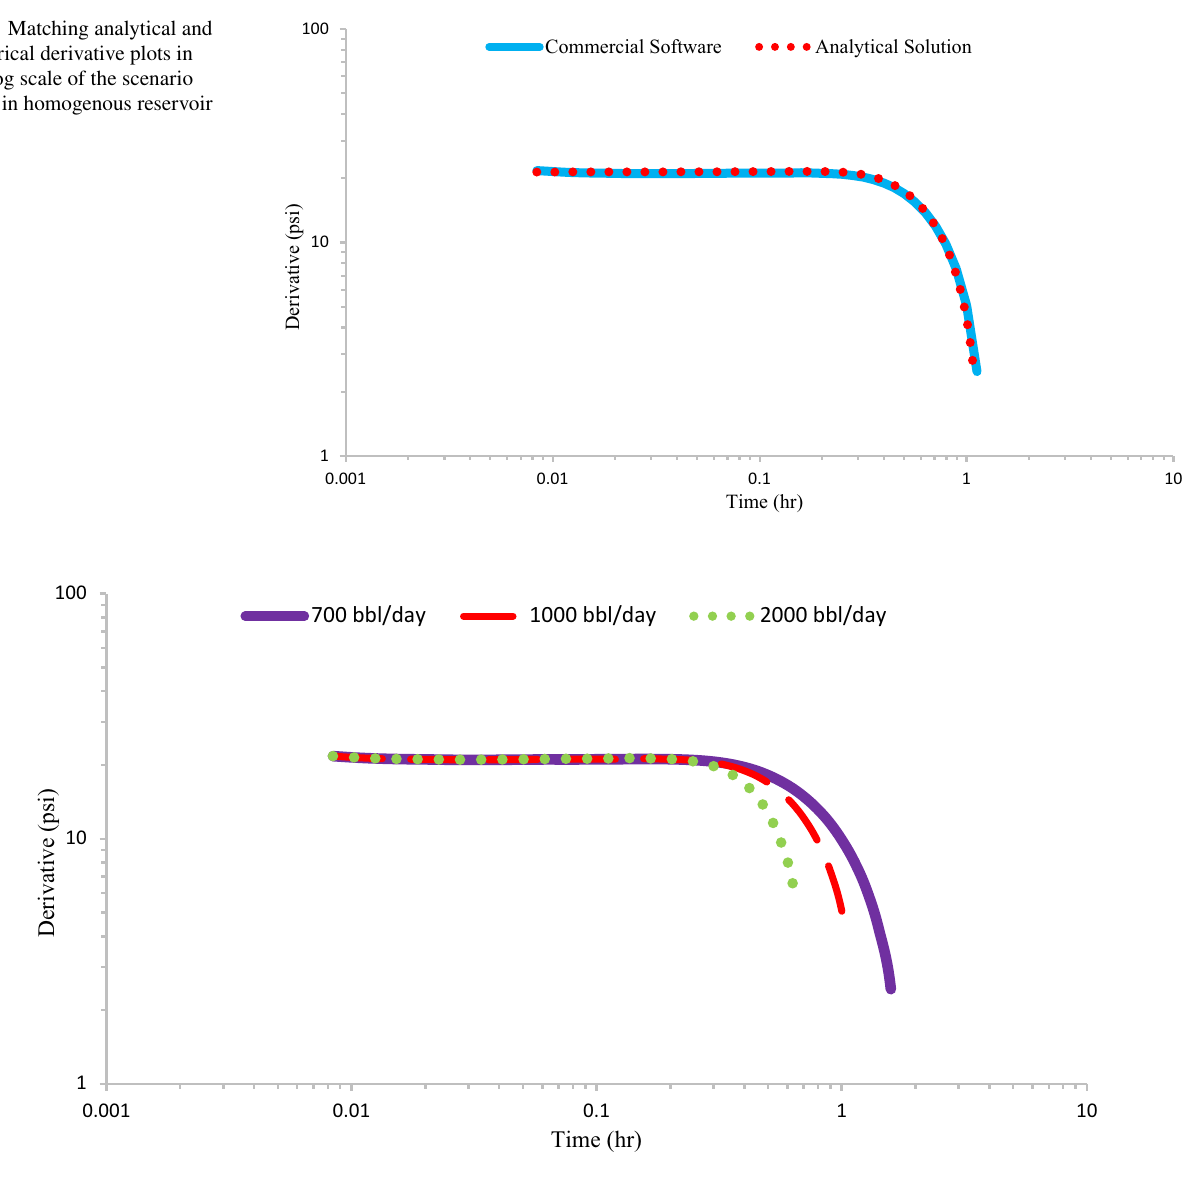
Fig. 8 Sensitivity analysis of scenario No. 2 on the rate of the adjacent well in homogenous